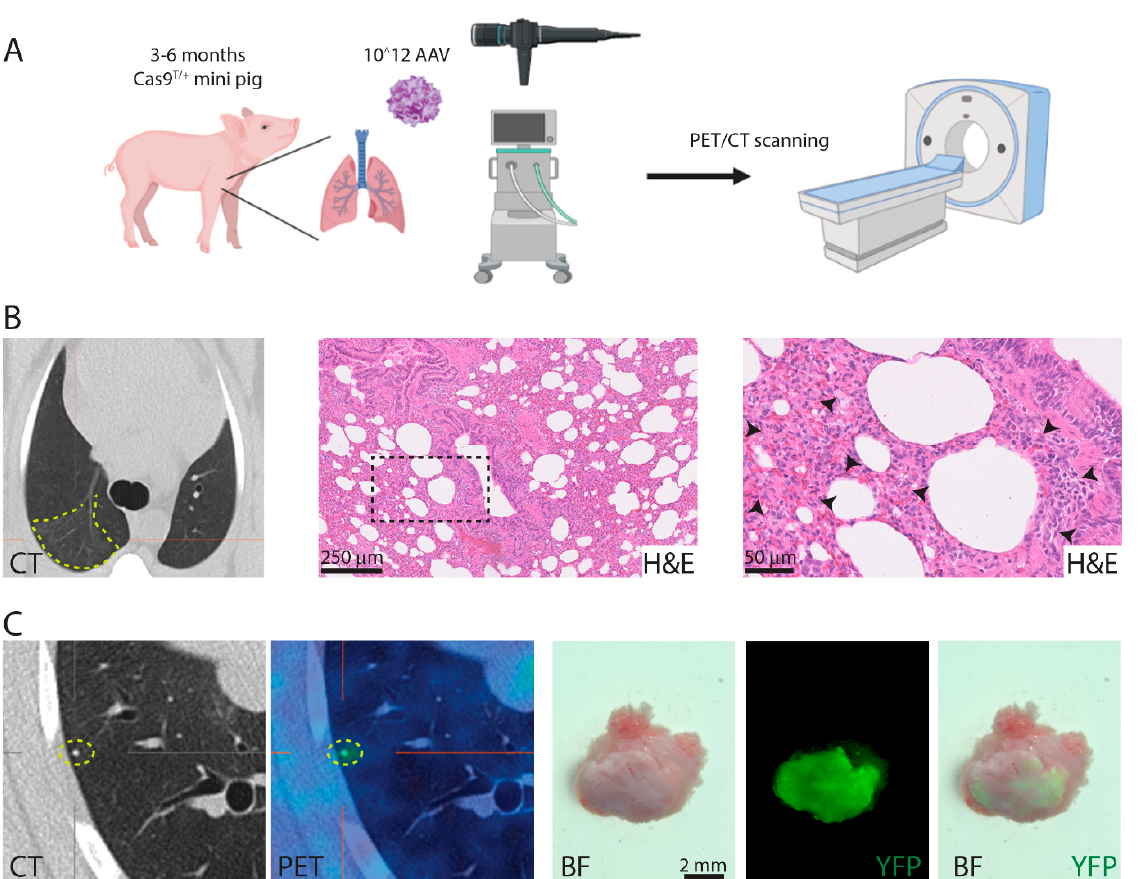
Figure 5. Delivery of AAV particles to the lungs. ( A ) Transgenic Cas9 pigs were transduced with 10 12 AAV particles by aerosol or through a bronchoscope. The pigs were PET/CT scanned up to three times over 18 months after AAV transduction. ( B ) Inflammation in a lung lobe after AAV induction. Histology analysis revealed chronic inflammation by infiltrating lymphocytes (marked by black arrowheads). ( C ) PET/CT scanning shows increase FDG uptake in area of 5 mm 3 . Analysis of the spot revealed calcification with auto-fluorescent seen as YFP.